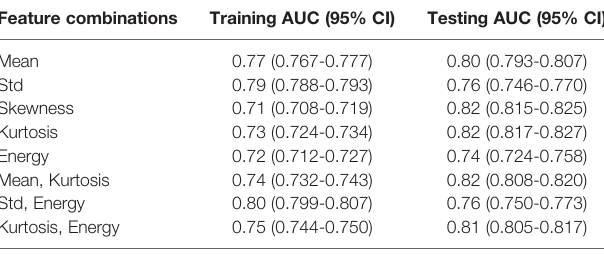
TABLE 3 | Training and testing mean AUC values for PAM-GLM classi fi ers developed using different combinations of weakly correlated features. Feature combinations